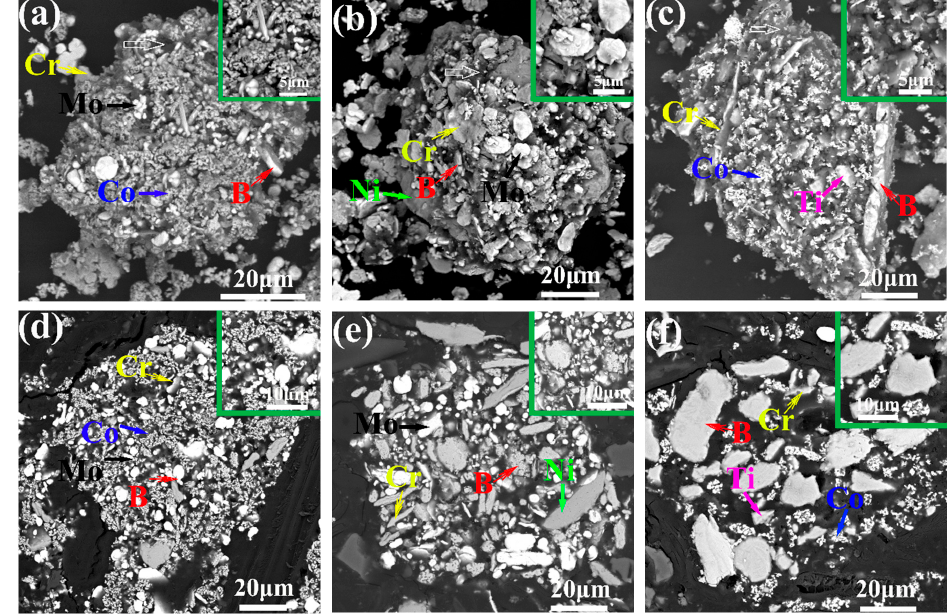
Figure 6. The surface and cross-sectional morphologies of mixture powders ( a , d ) Mo–B–Co–Cr; ( b , e ) Mo–B–Ni–Cr; and ( c , f ) Ti–B–Co–Cr respectively.